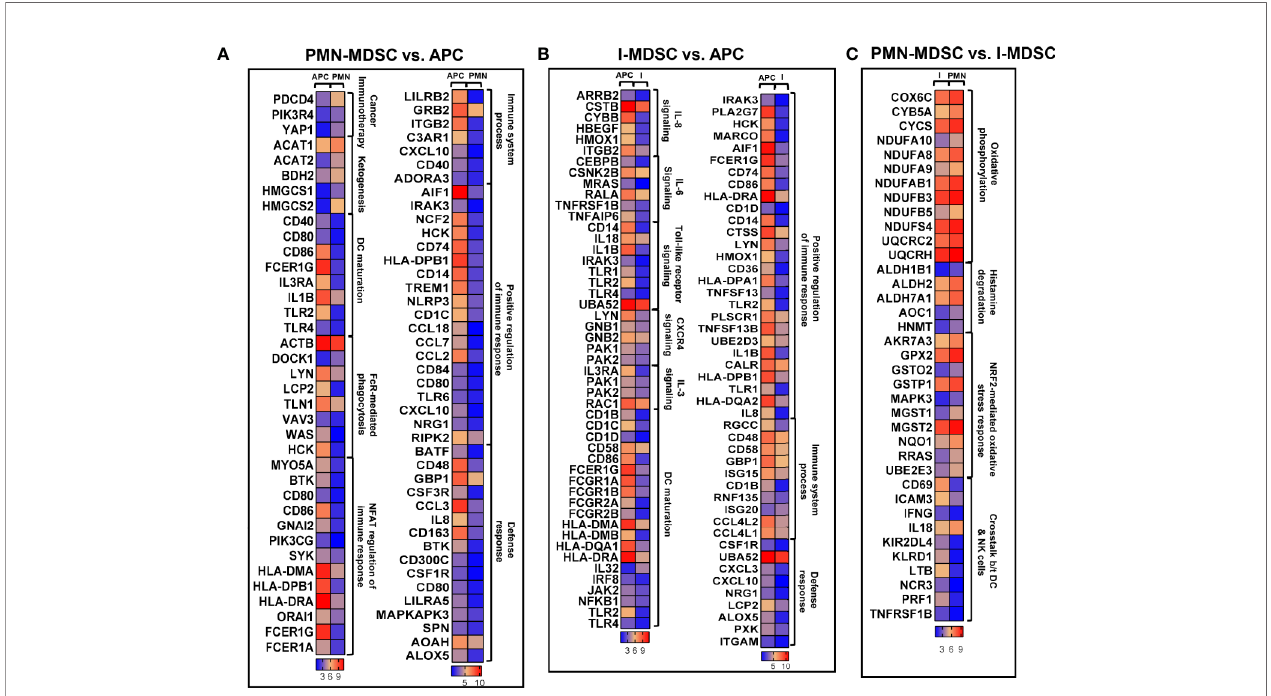
FIGURE 3 | Differential gene expression of PMN-MDSCs, I-MDSCs and APCs in CRC tumor microenvironment. Functional categorization of top signi fi cantly upregulated and downregulated transcripts (with a fold change > 2, P value cutoff < 0.05) from CLC analysis were analyzed through IPA. Heat maps show the TPM representing fold change relative to the mean expression in PMN-MDSC (denoted as PMN) vs. APC (A) , I-MDSC (denoted as I) vs. APC (B) and PMN-MDSC vs. I- MDSC (C)